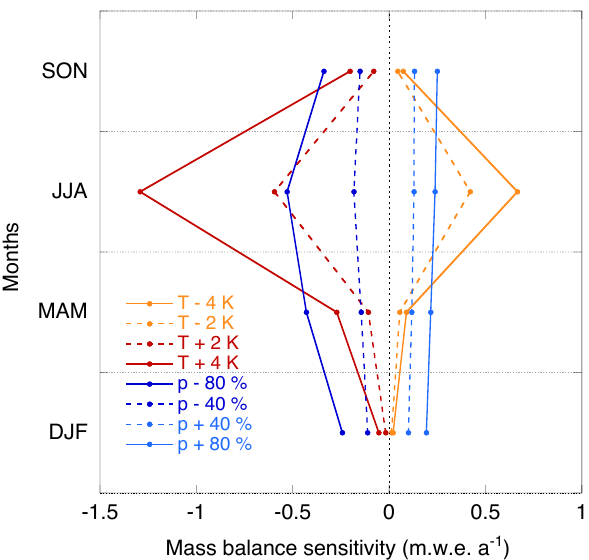
Fig. 14. Annual mass balance sensitivity to seasonally perturbed temperatures (red) and precipitation (blue) over the period 2000–